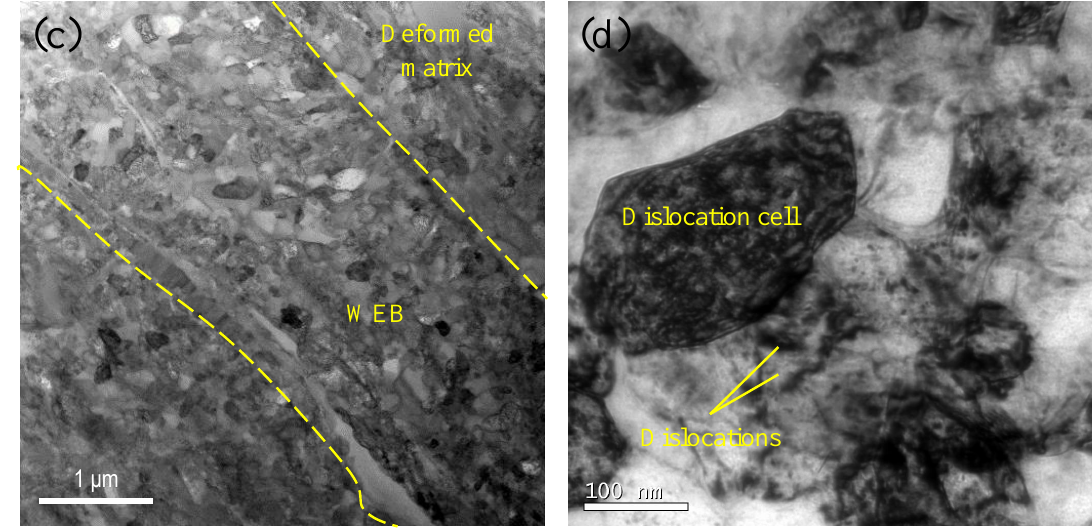
Figure 7. FIB/TEM characterisation on a WEB. ( a ) TEM lamella containing a WEB prepared by FIB. ( b – d ) TEM images of the WEB at different